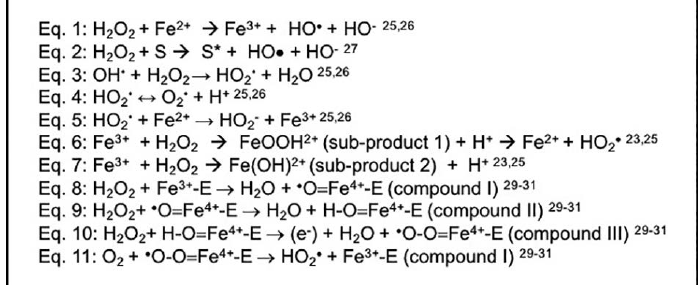
Figure 4- Degradation of H2O2 in the presence of chemical activators. Eq.=equation. S=substrate. S* oxidized substrate.